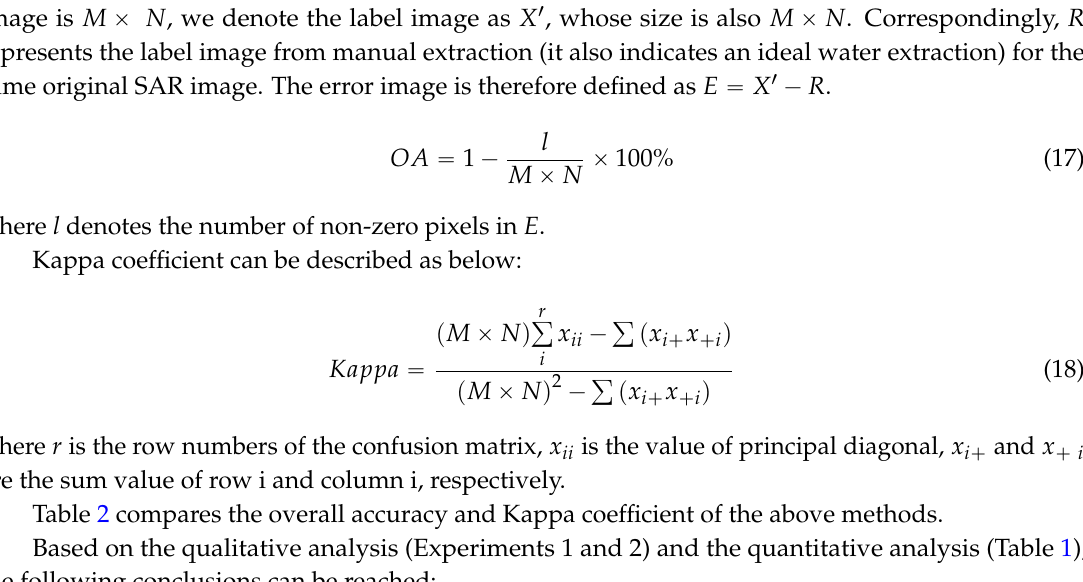
Table 2. Overall Accuracy and Kappa Coefficient Comparison.